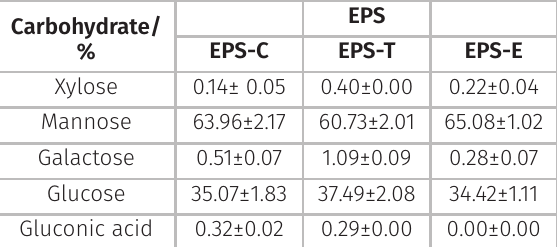
Figure 1. Elution profile (a) in Sepharose CL-6B chromatography and the FT-IR spectra (b) of the EPS produced by submerged culture of I. rickii by treatment of Tween 40 (EPS-T) and ethanol (EPS-E), respectively. EPS-C means without addition. Elutes were analyzed by measuring the absorbance at 480 nm for carbohydtate. Table II. Carbohydrate composition of the purified Inonotus rickii exopolysaccharides (EPS) produced with Tween 80 or